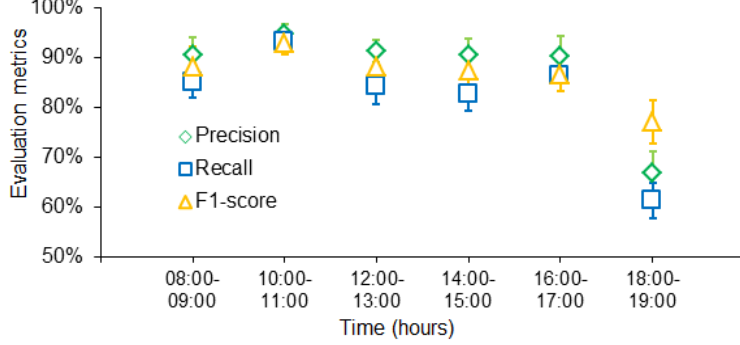
Figure 9. Ten day average detection results at different time intervals.